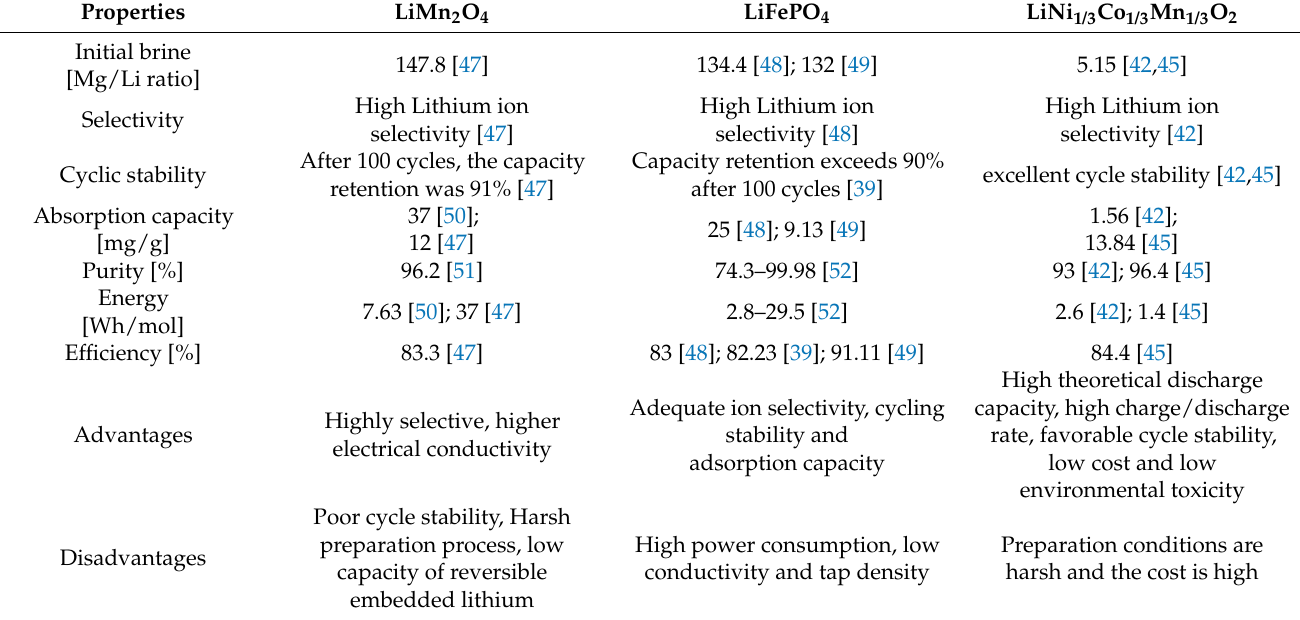
Table 1. Summary of lithium extraction performance of three electrode